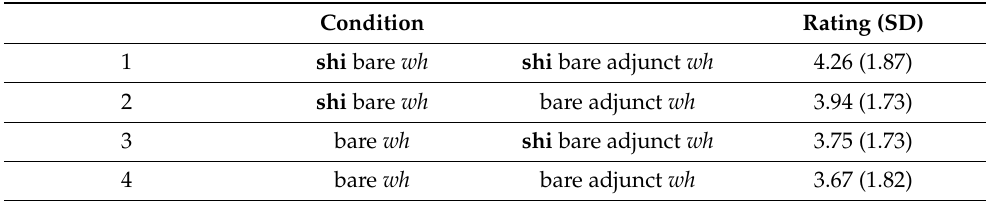
Table 11. Mean acceptability ratings in sub-experiment 3’.